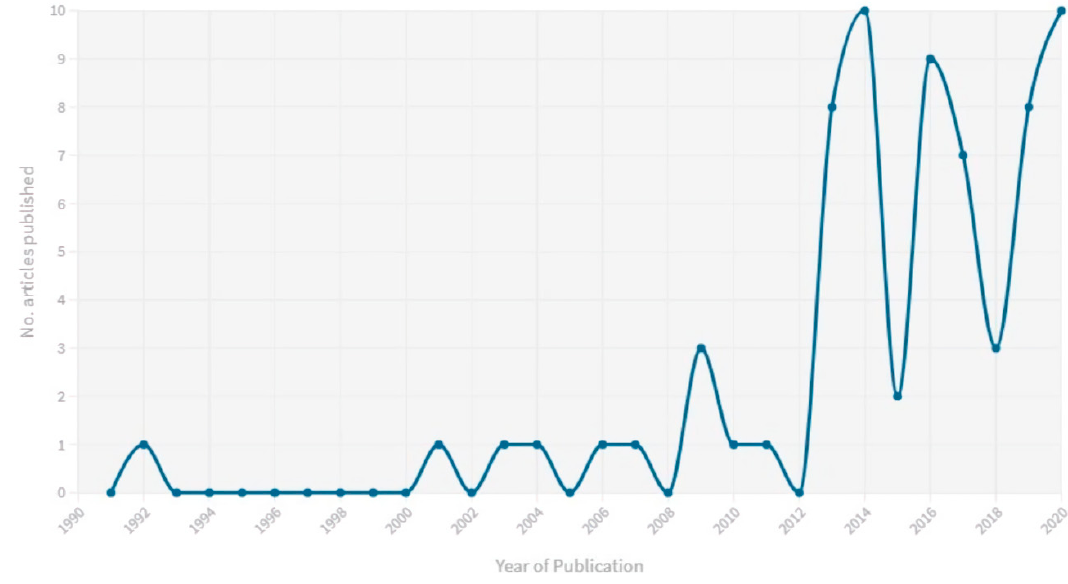
Figure 2. Publication year of included studies.